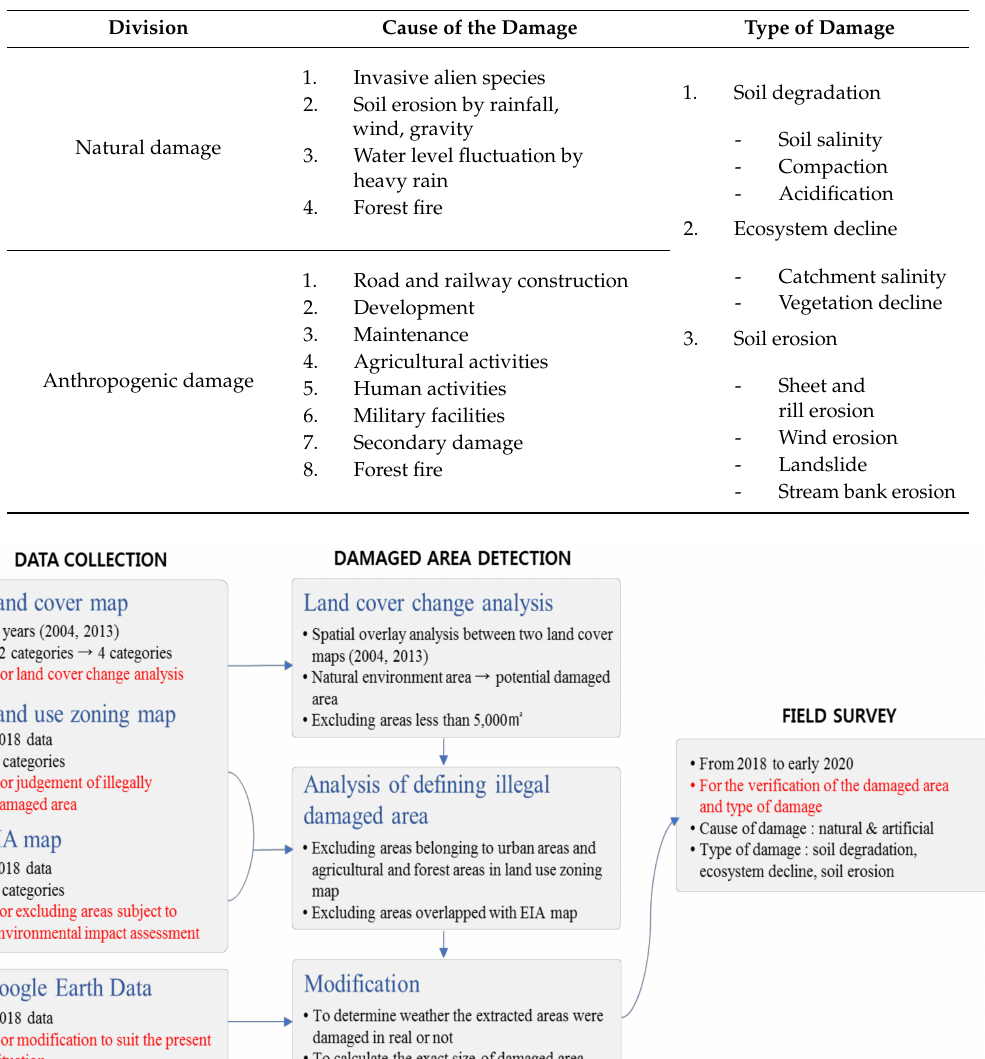
Table 3. Field survey criteria for damage classification.